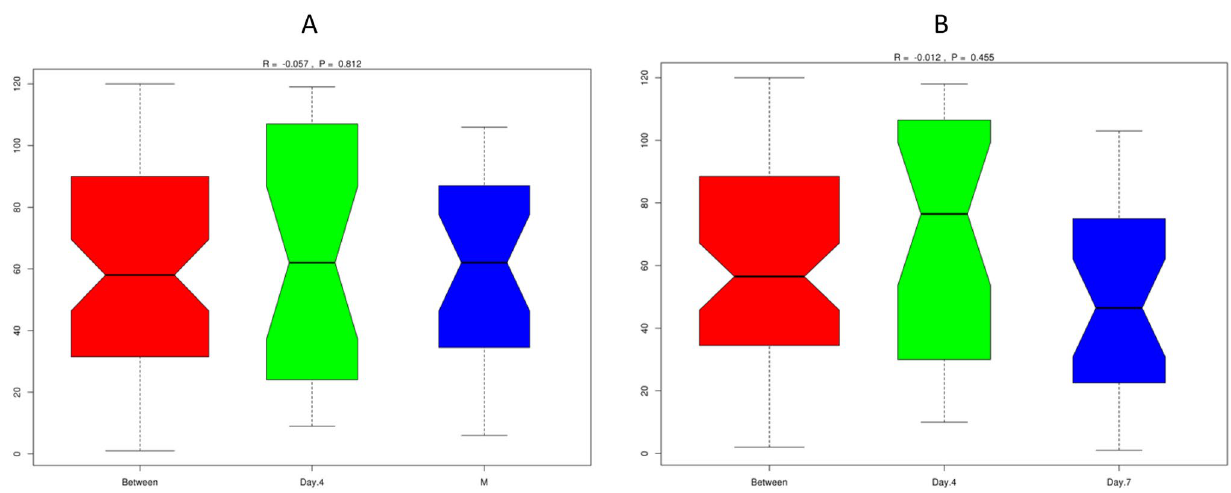
Figure 4. ANOSIM results for the feces microbiome at the three time points. Unweighted UniFrac distances between microbiome communities of subjects’ feces within the three time points, for comparisons between each of the two groups, i.e., M with day 4 ( A ) and day 4 with day 7 ( B ). No significant differences were observed (high P -values, 0.812 and 0.455). Generated by using R Software 24